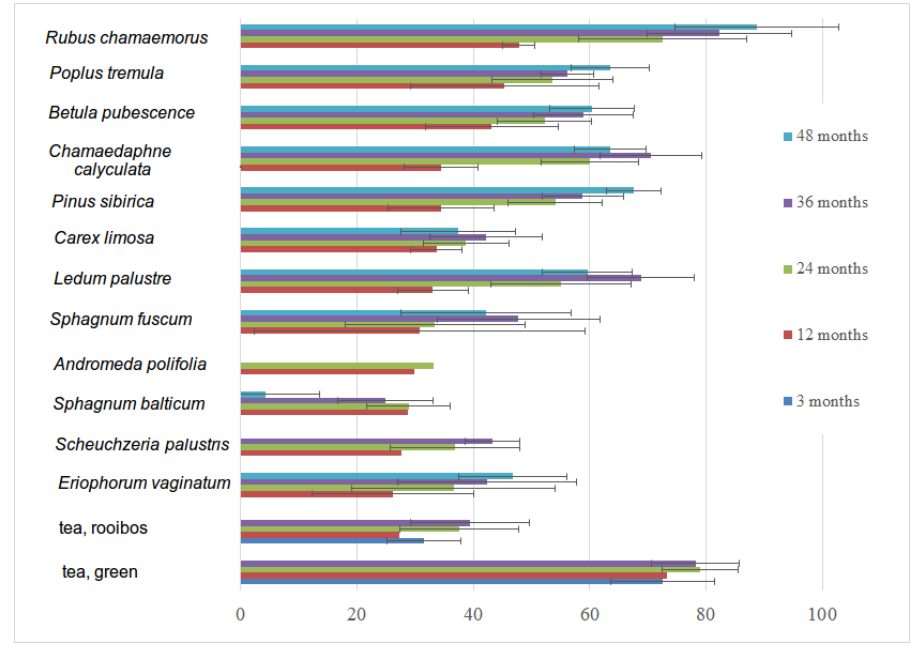
Figure 9. The mean weight loss of different litter types with standard deviation for 1 to 4 years of decomposition.